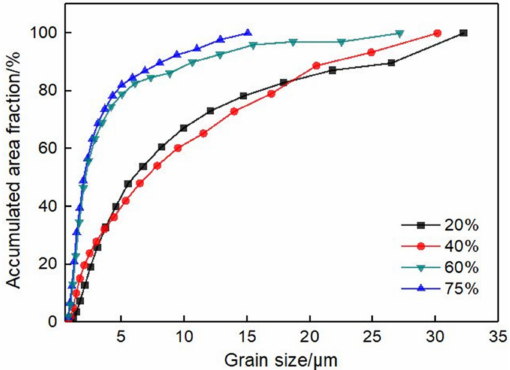
Figure 9. Grain size distributions at different deformation